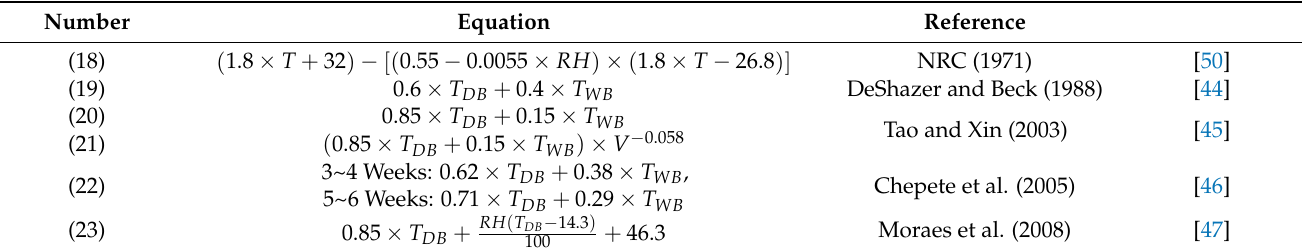
Table 6. Heat stress index model for